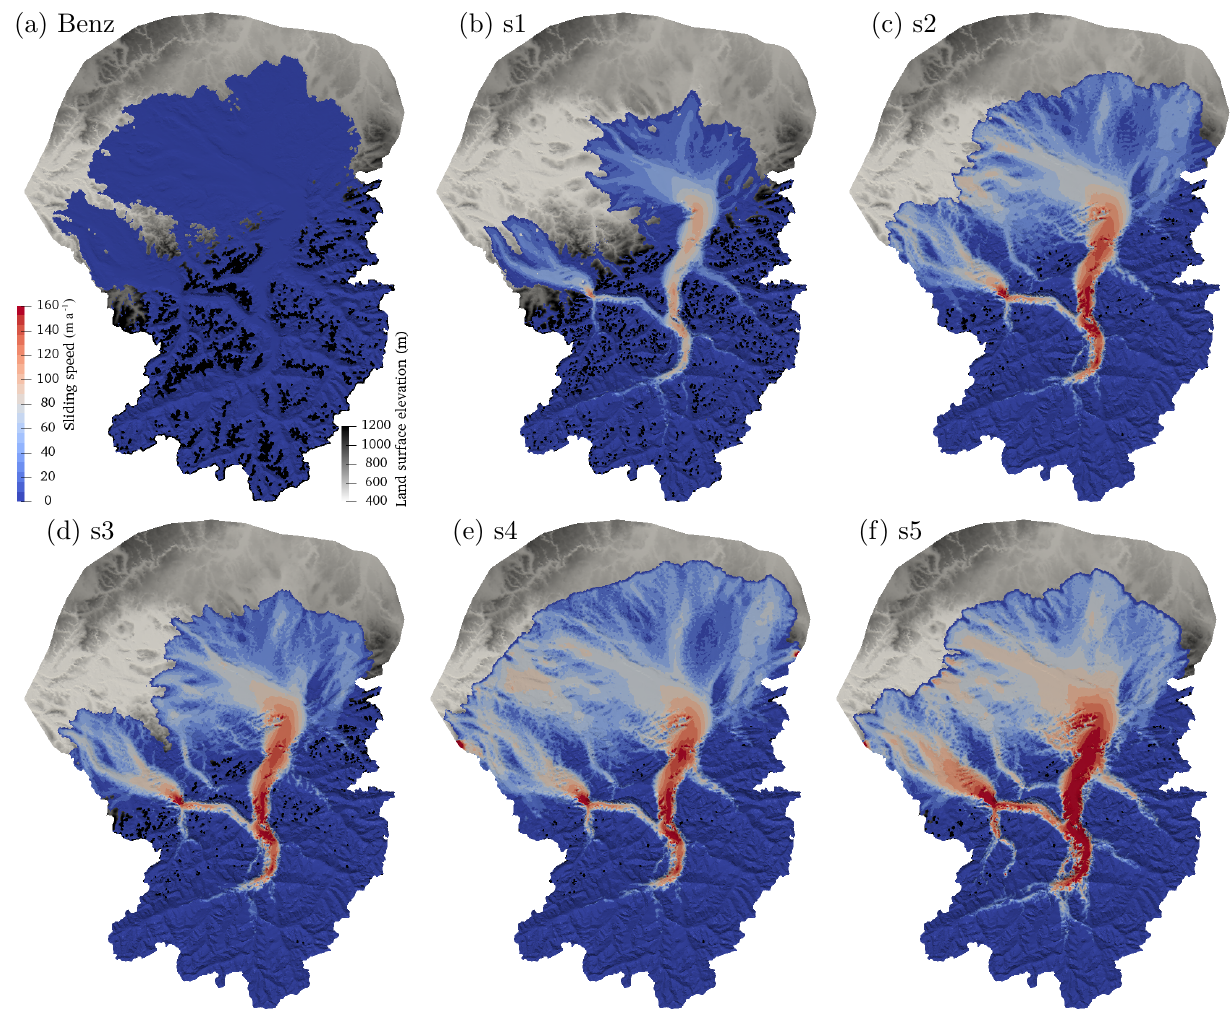
Figure 9. Ice sliding speed in meters per year for (a) Benz-Meier (2003) (no sliding assumed) and (b–f) simulations